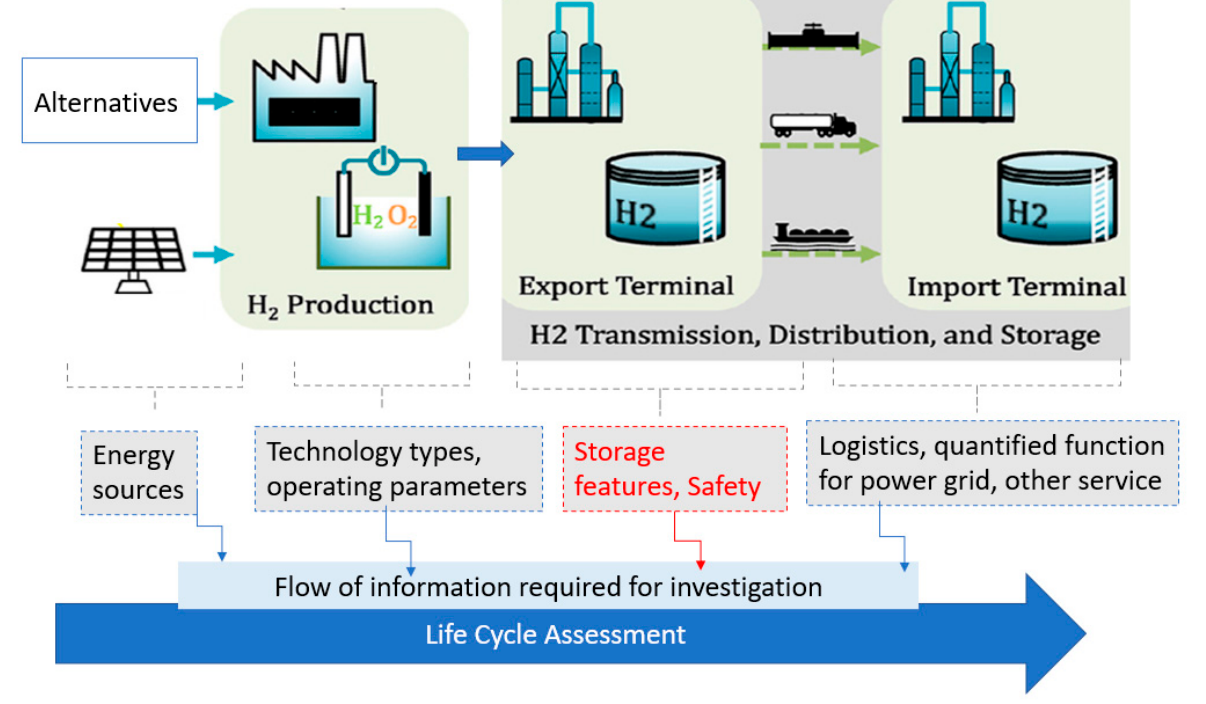
Figure 5. LCA stages recommended for hydrogen production (adapted/modified from Hong et al.